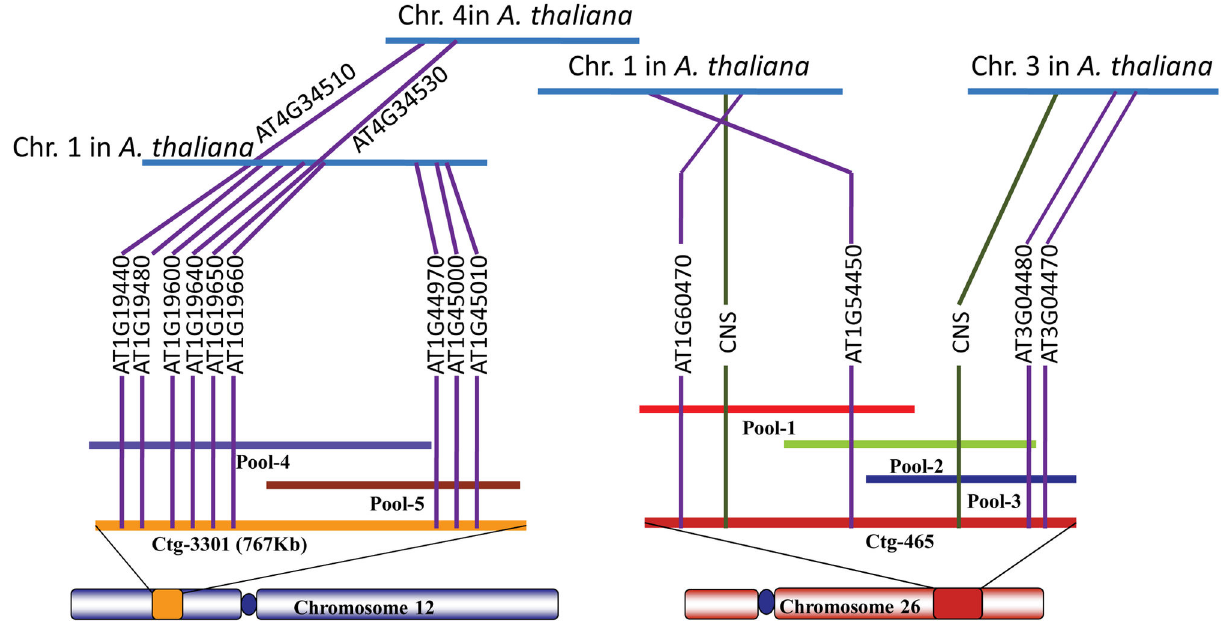
Figure 3. Comparative genomic analysis of Ctg-3301 (Chromosome A12) and Ctg-465 (Chromosome D12) of Upland cotton with Arabidopsis